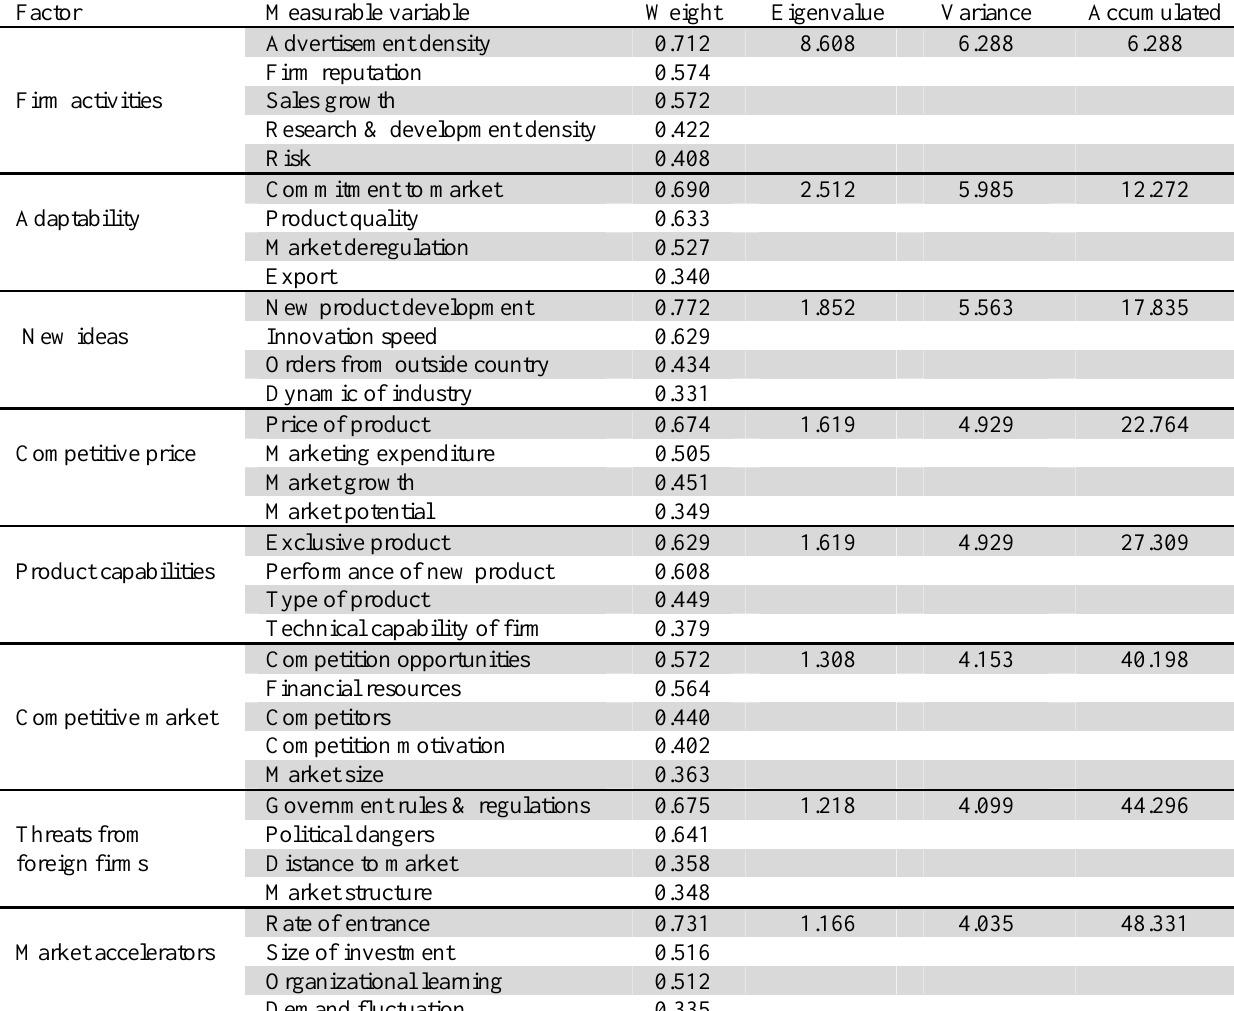
Table 3 The summary of factor analysis